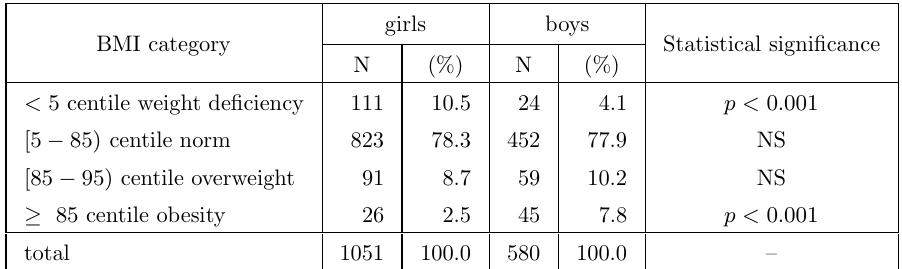
Table 1. The assessment of BMI in the examined group of students according to